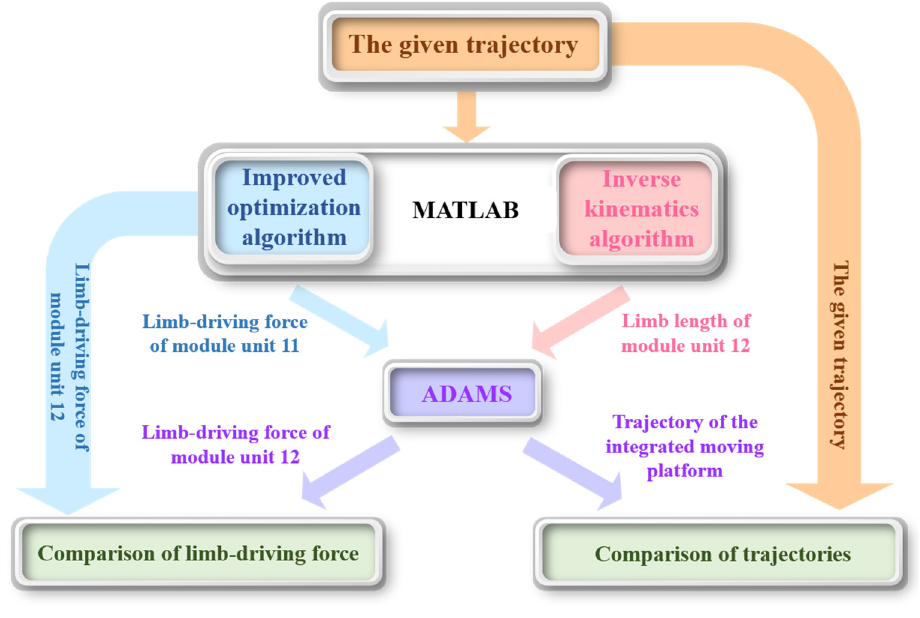
Figure 5. Co-simulation flowchart. Figure 5. Co ‐ simulation flowchart. Figure 5. Co ‐ simulation flowchart.